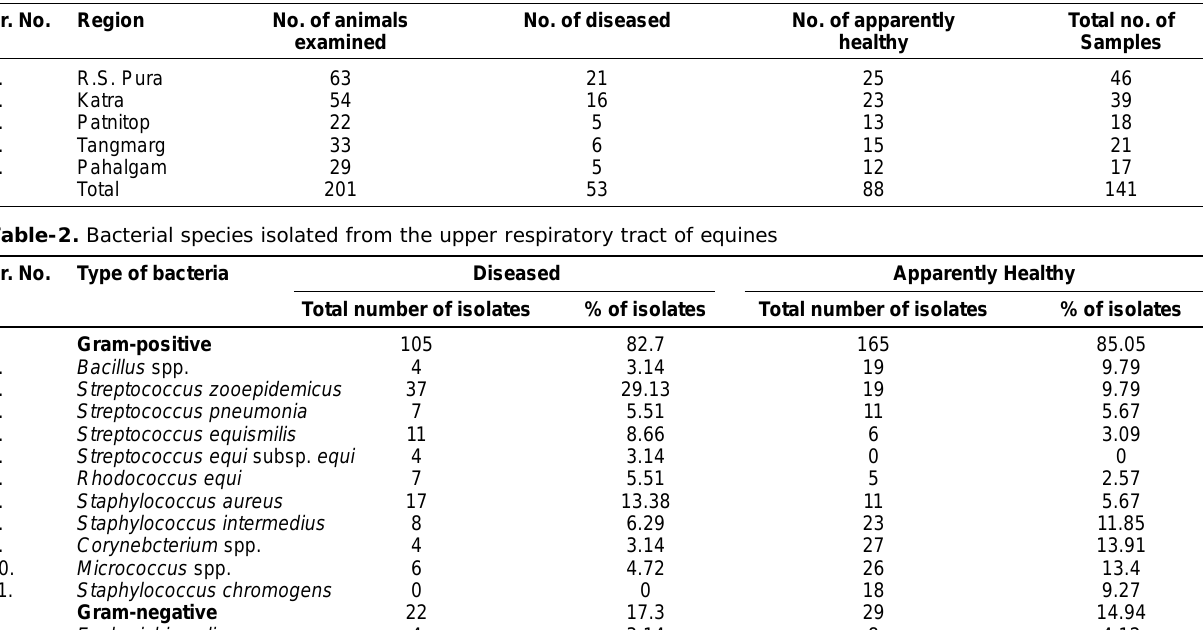
Table-1. Area wise details of sample collection